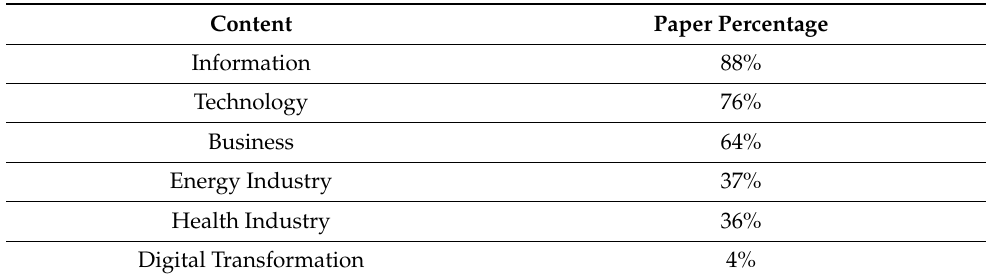
Table 1. Paper content with the term “big-data